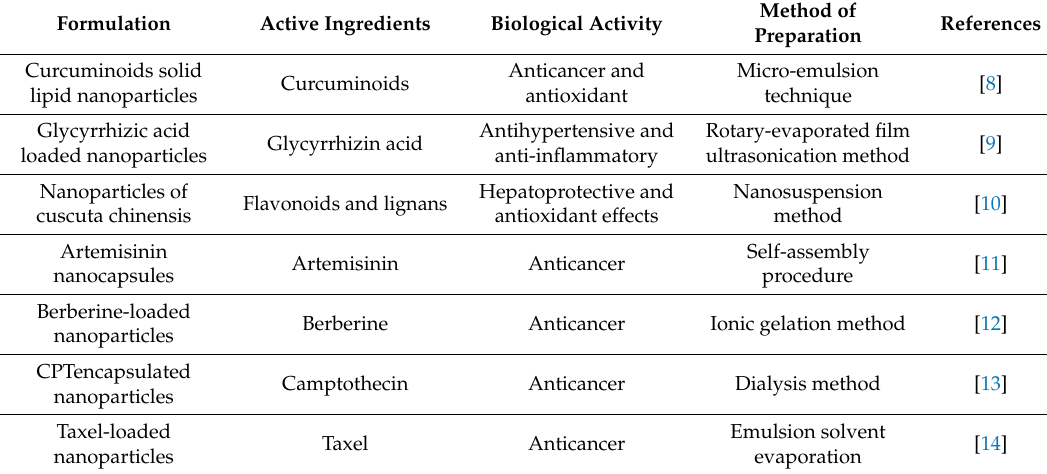
Table 1. Herbal drug-loaded nanoparticles.